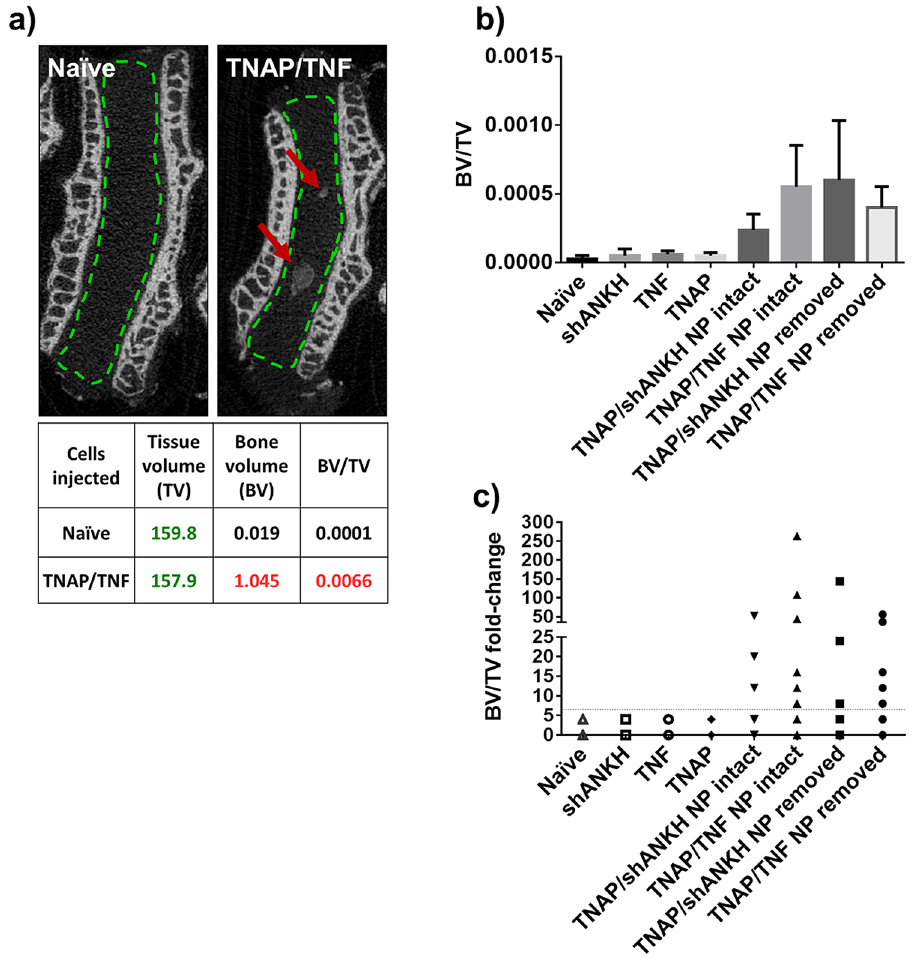
Figure 5. Mineral content increased in IVD injected with TNAP/TNF transduced bNPs. ( a ) µCT image of rabbit discs injected with naïve and TNAP/TNF double-transduced cells; The tissue volume (TV), bone volume (BV) and new mineral formation (BV/TV) for the representative images are given in the table below the image; ( b ) new mineral formation in IVD injected with transduced cells assessed by µCT; the results presented as mean and standard error of all discs in a given group; ( c ) BV/TV of discs injected with transduced cells represented as a fold-change, compared to mean BV/TV in disc injected with naïve bNPs (n =